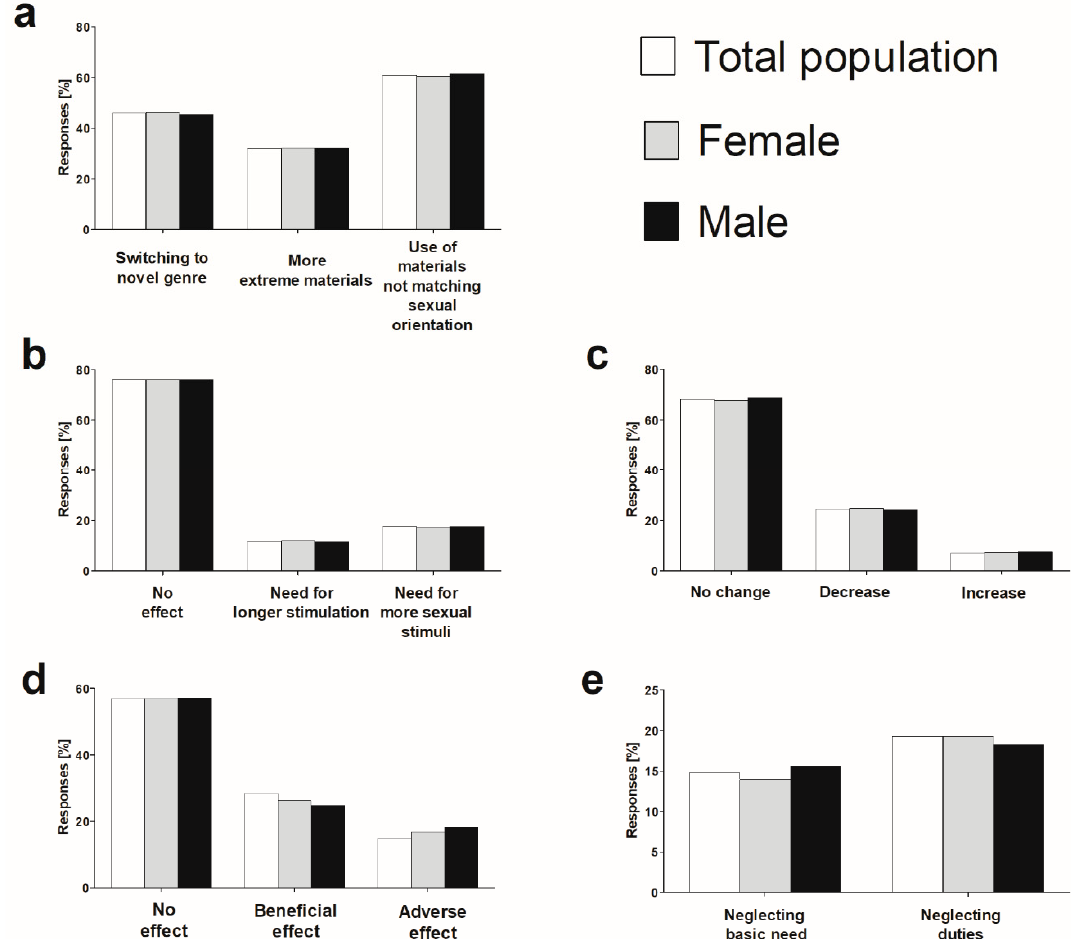
Figure 2. The self-perceived changes in the pattern of pornography use in the course of its consumption ( a ), the reported self-perceived e ff ects of pornography consumption on sexual performance during its consumption ( b ), sexual satisfaction ( c ), romantic relationship quality ( d ), and neglecting basic needs and duties at least once in their lifetime ( e ) in the surveyed group of university students ( n = 4260).